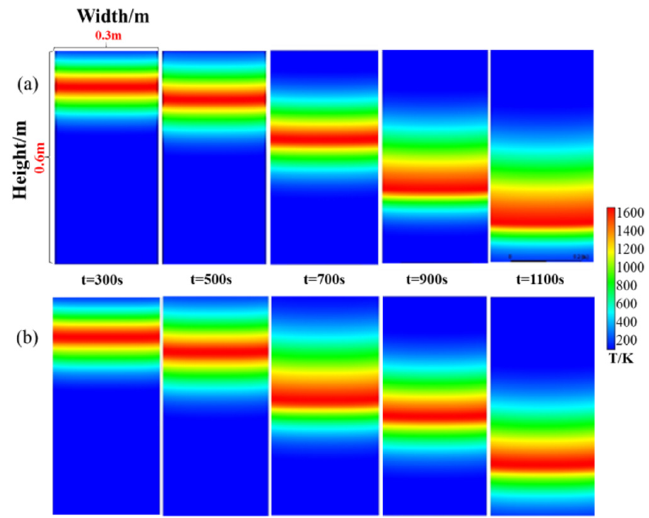
Figure 10. Temperature distributions at various times. ( a ) base case; ( b ) case